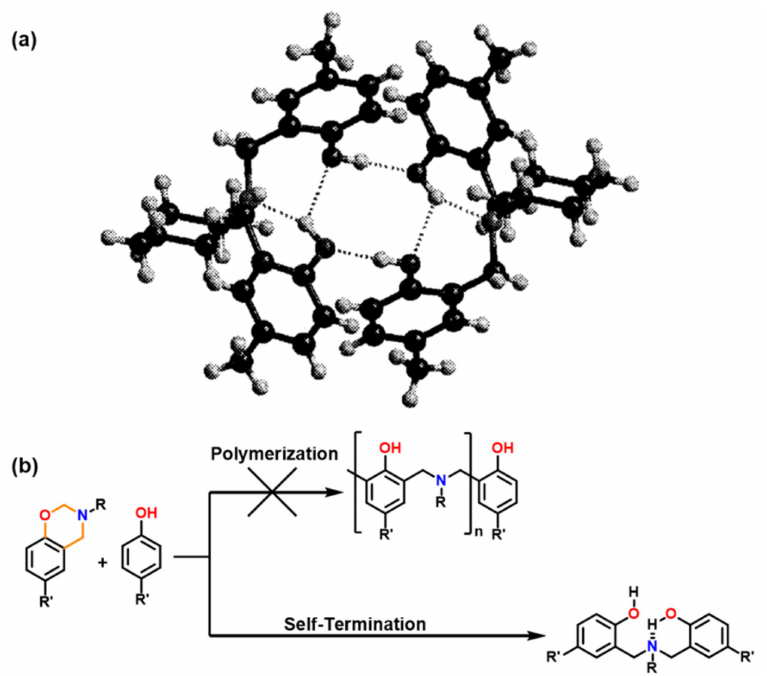
Figure 56. ( a ) Dimer 1 packing structure [80]. Copyright 2001. Reproduced with permission from American Chemical Society. ( b ) Self-termination of ring opening reaction of p -substituted